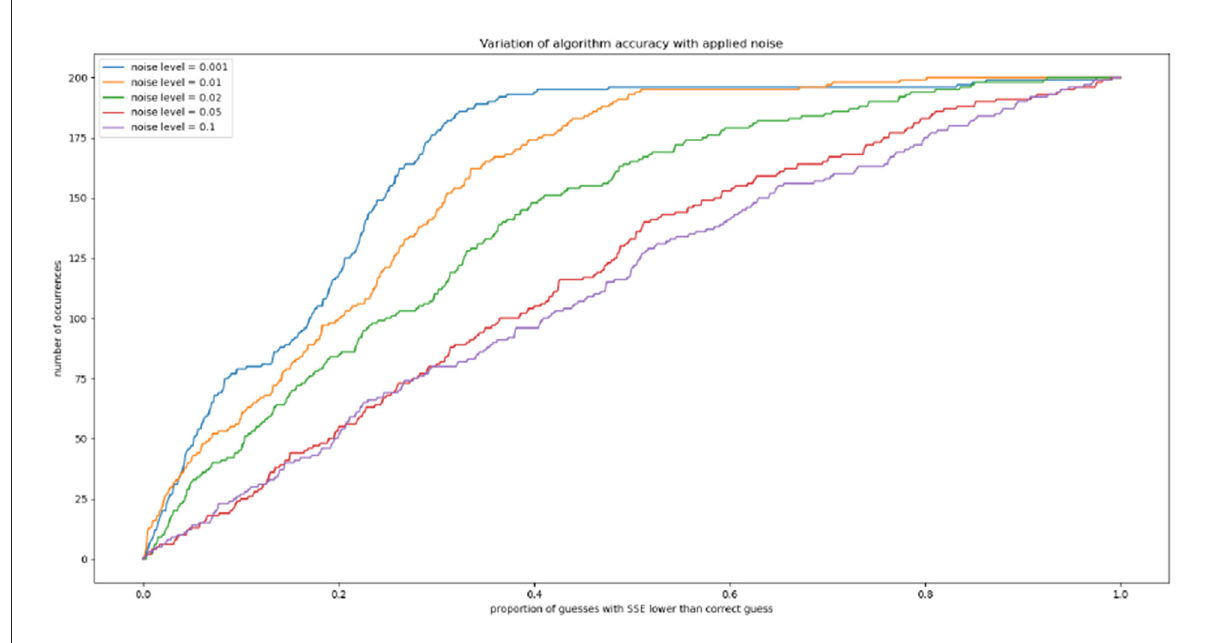
FIGURE5 The effect of randomly-generated noise on algorithm